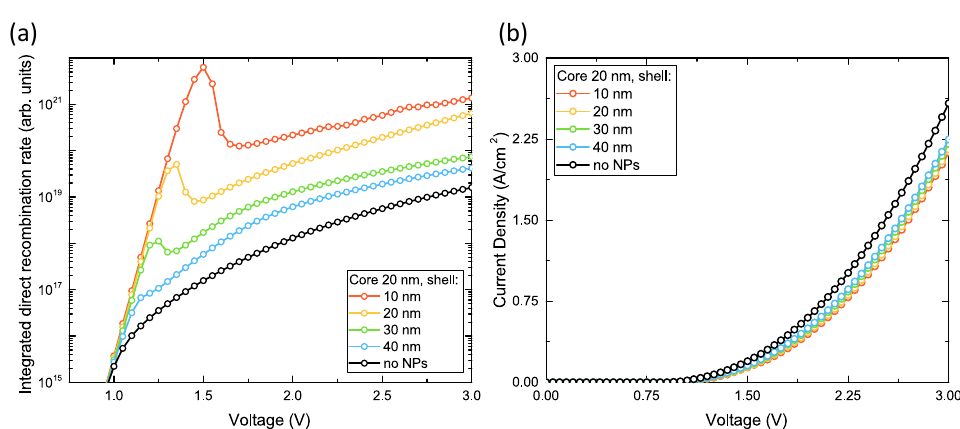
Figure 4. Calculation of optimal shell thickness: ( a ) integrated direct recombination rate for single NP ( b ) I–V curves of the device. Core diameter is fixed and equals 20 nm.